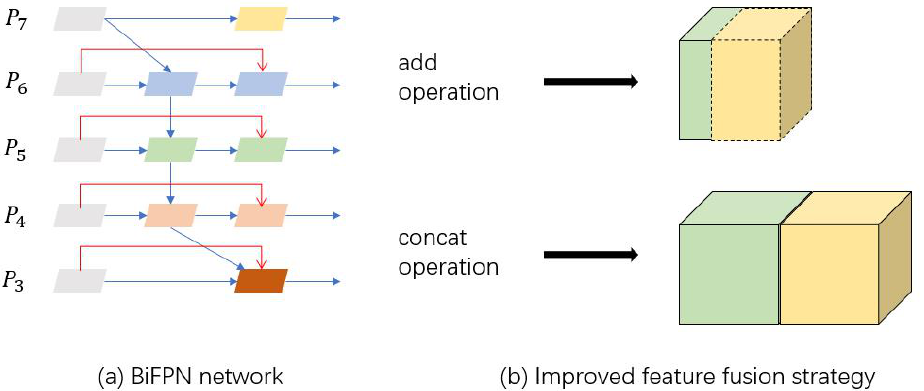
Figure 1. The flow diagram of the improved BiFPN